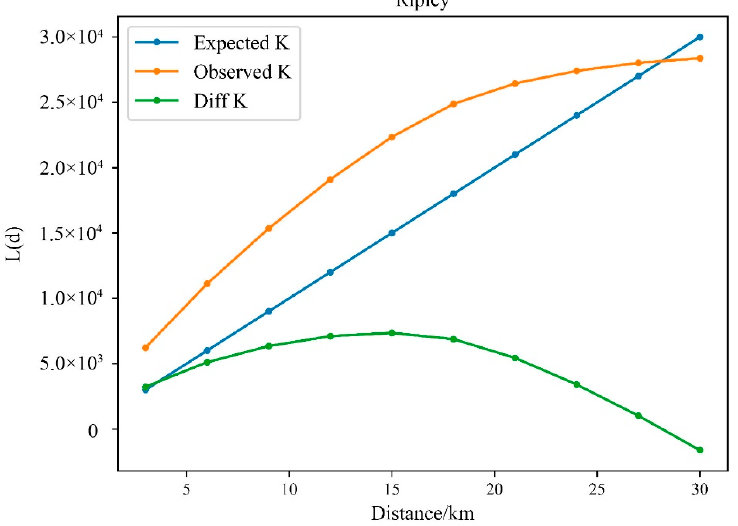
Figure 5. Ripley’s L(r) function results for digital signage.